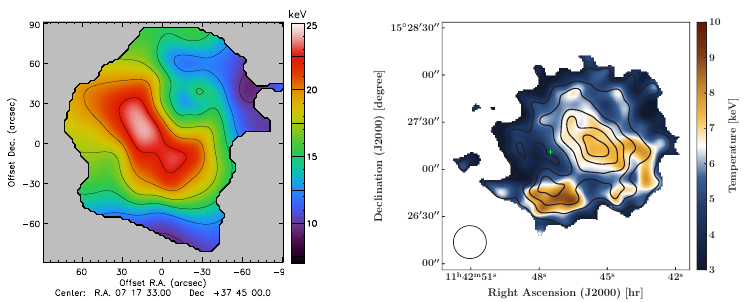
Figure 1. Left: Spectroscopic temperature map derived from Chandra for a cluster at z = 0 . 55. Right: Temper- ature map obtained from the joint analysis of Chandra X-ray and NIKA2 SZ observations for a cluster at z = 1 . 2. The relative uncertainties on temperature are similar in both panels. Figures extracted from [7,